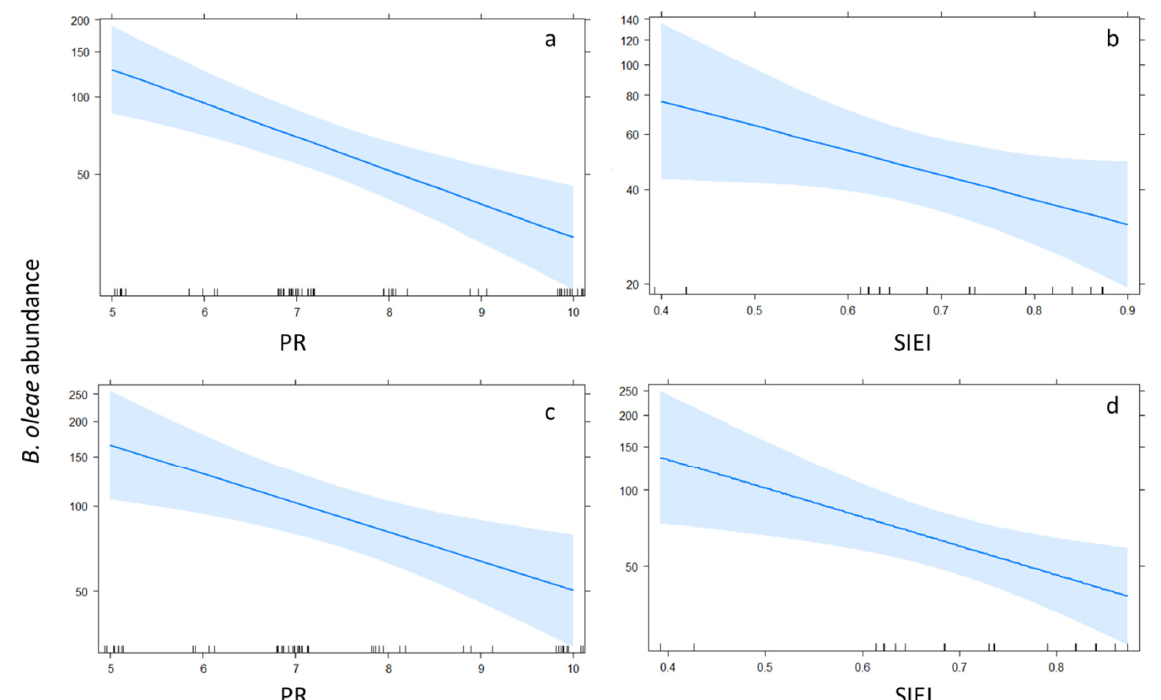
Figure 4. Effect of landscape structure on Bactrocera oleae abundance in spring 2015 ( a ), autumn 2015 ( b ), spring 2016 ( c ) and autumn 2016 ( d ). Landscape indices were patch richness (PR) and Simpson landscape diversity index (SIEI) calculated at 1000 m buffer areas.